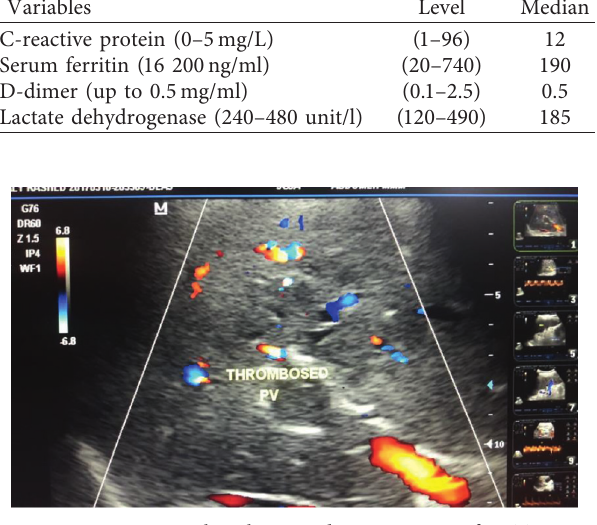
Figure 1: Doppler ultrasound examination of